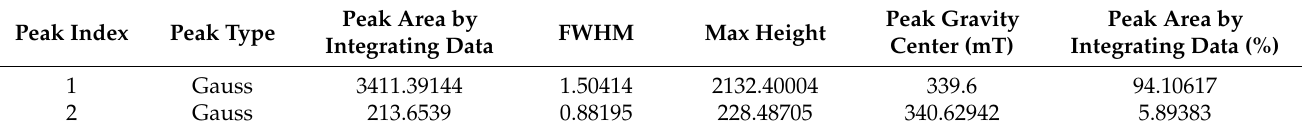
Table 2. Approximation parameters of the EPR signal for a sample with 25 coating layers, when the spectrum is decomposed into